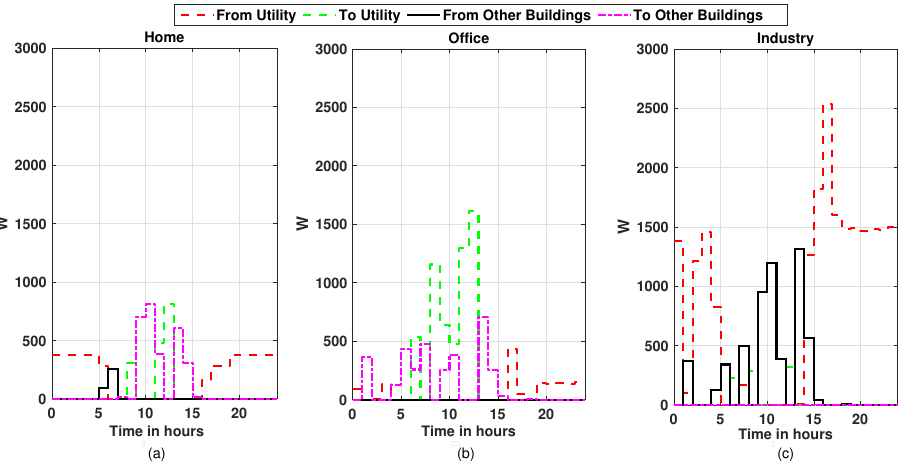
Figure 6. Electricity cooperation among the buildings for 24 h in the month of November, ( a ) for the home building, ( b ) for office building, and ( c ) for industry